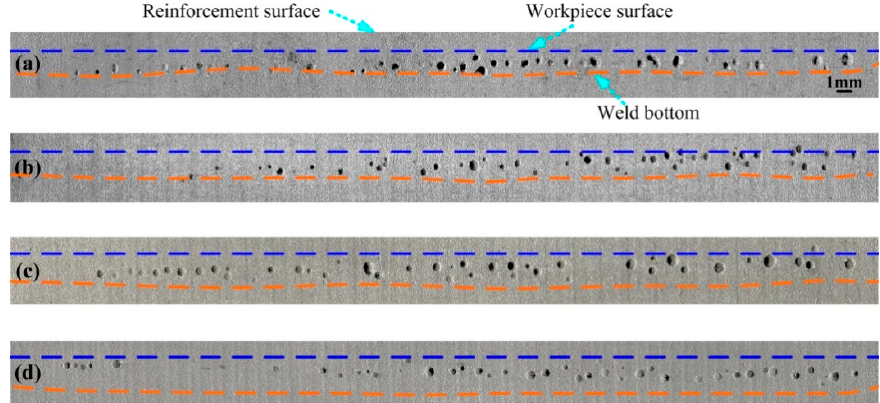
Figure 6. Pore distributions at the longitudinal section of the weld bead under different welding currents: ( a ) I = 100 A, ( b ) I = 140 A, ( c ) I = 160 A, and ( d ) I = 200 A.